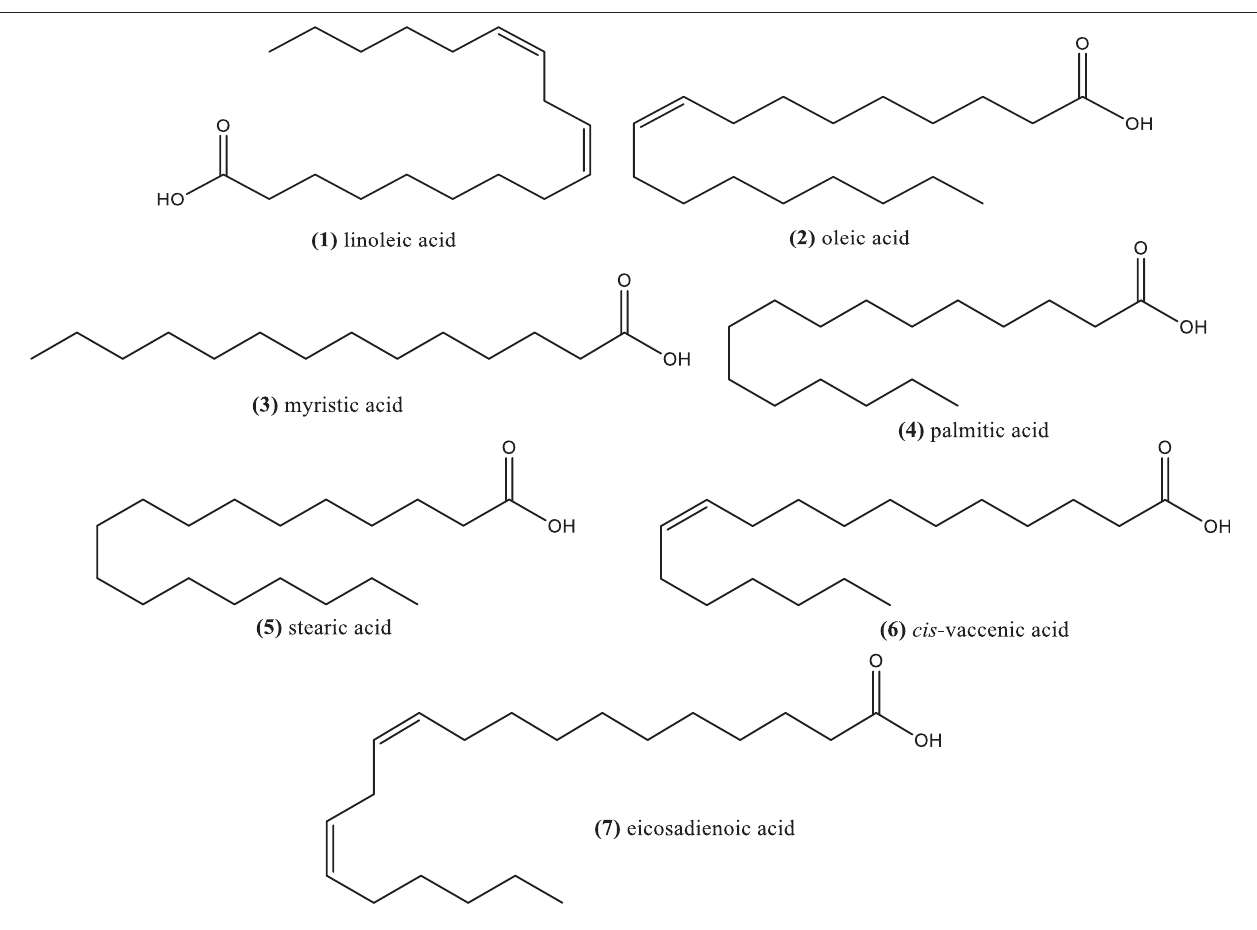
FIGURE 1 | Fatty acids in fi xed oils from Nigella